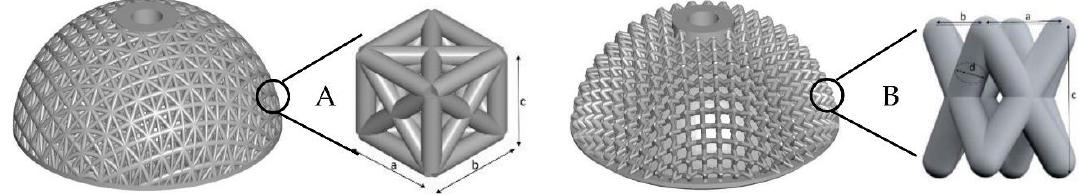
Figure 1. Illustration of the artificial press-fit cups, which are constructed with an open-porous, load-bearing unit cell; ( A )—combined unit cell, ( B )—twisted unit cell.